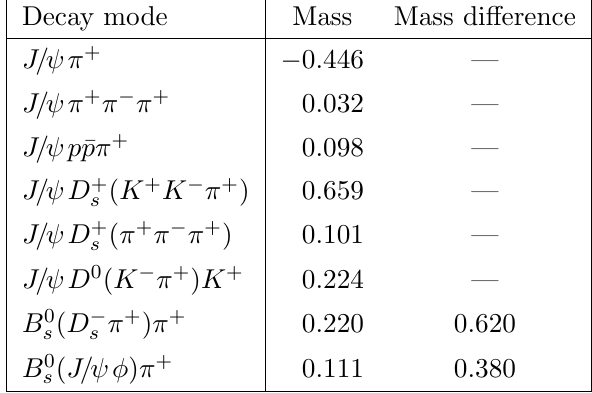
mass and the mass di(cid:11)er- c